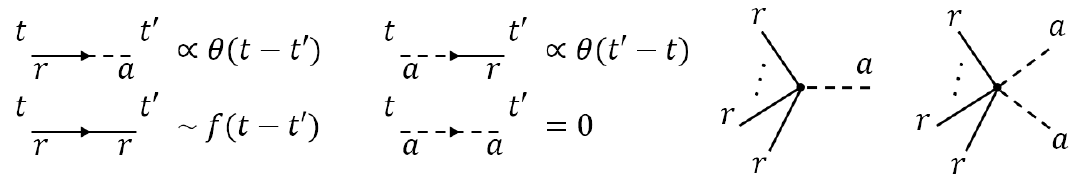
Figure 2 . Schematic Feynman rules for (3.1). Dashed lines correspond to (cid:31) a ’s, solid lines corre- spond to (cid:31) r ’s. The r (cid:0) a propagator should be proportional to (cid:18) ( t (cid:0) t 0 ) while the a (cid:0) r propagator should be proportional to (cid:18) ( t 0 (cid:0) t ). r (cid:0) r propagator (with some function f ) is non-vanishing for either orderings of t and t 0 . All the interacting vertices contain at least one a